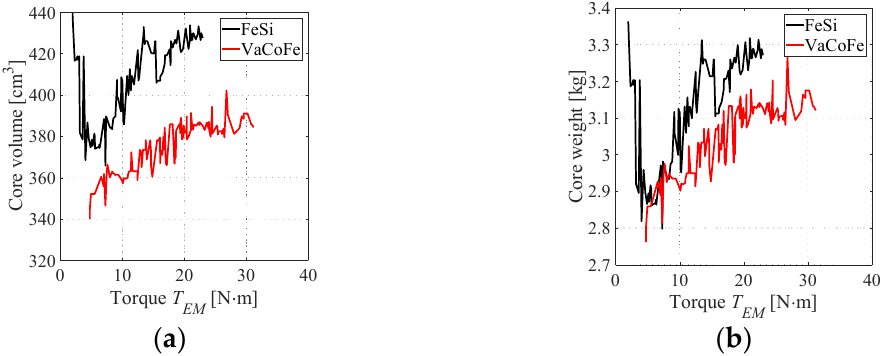
Figure 15. Core ( a ) volume and ( b ) weight of the last generation for FeSi and VaCoFe cores.